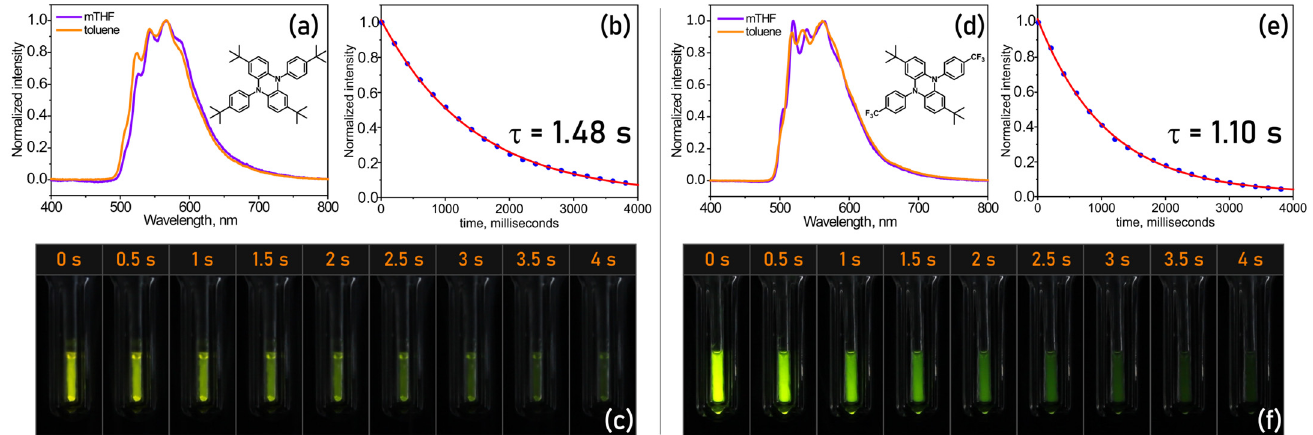
Figure 4. The phosphorescence spectra of Phz1 ( a ) and Phz2 ( d ) in various solvents (2-methyl-THF or toluene matrix at 77 K) and the phosphorescence lifetimes in the 2-methyl-THF matrix ( b , e ). Phosphorescence observed for Phz1 ( c ) and Phz2 ( f ) after the excitation source was turned